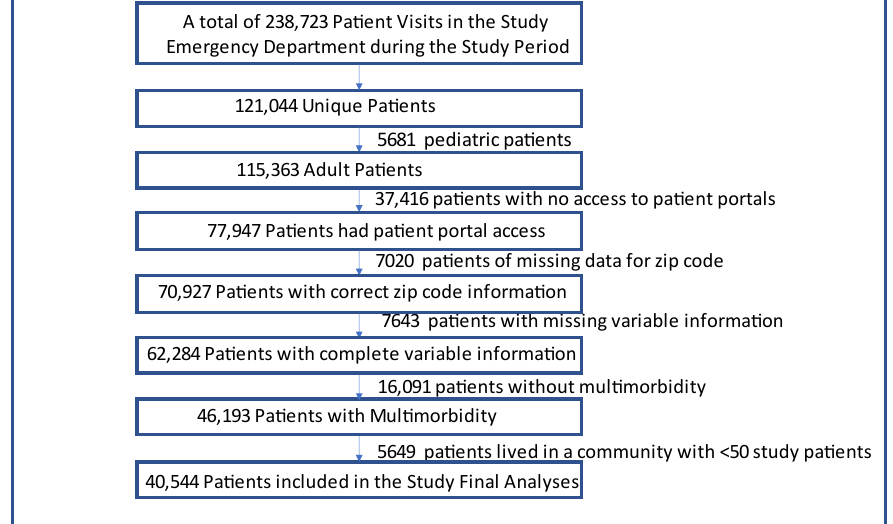
Figure 1. Study flow